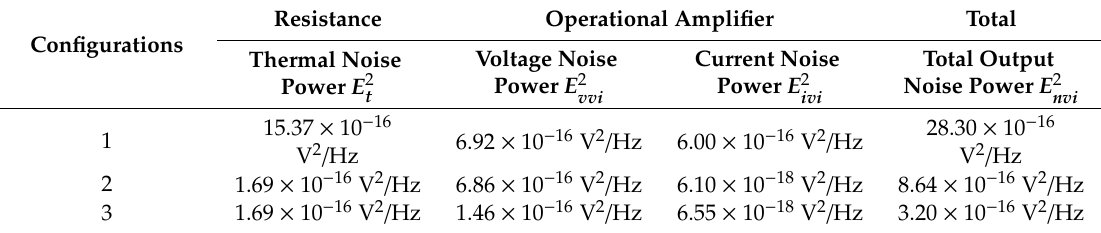
Table 3. Noise contribution of each part under di ff erent